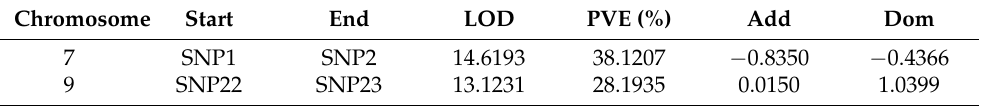
Table 2. Quantitative trait loci ( p < 0.05) associated with anthocyanin biosynthesis in broccoli.